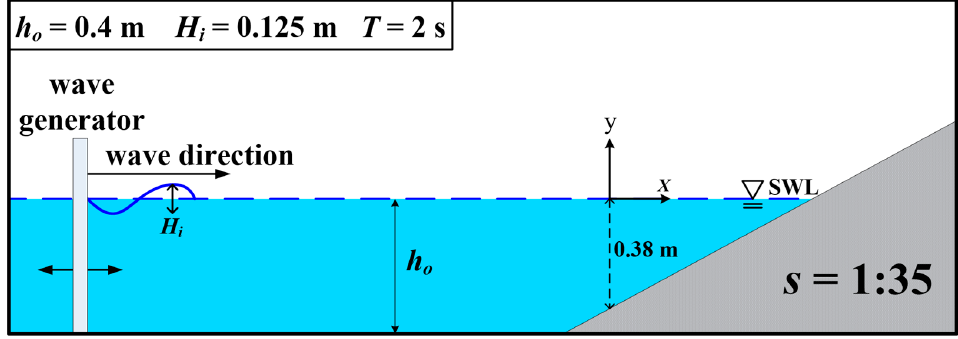
Figure 1. Schematic diagram of a periodic wave propagating on a slope seawall ([4]). The mesh sizes in the computational domain are arranged, and the time step is set to 0.002 s. The finer grids are arranged in the area close to sloping bed, where the waves will